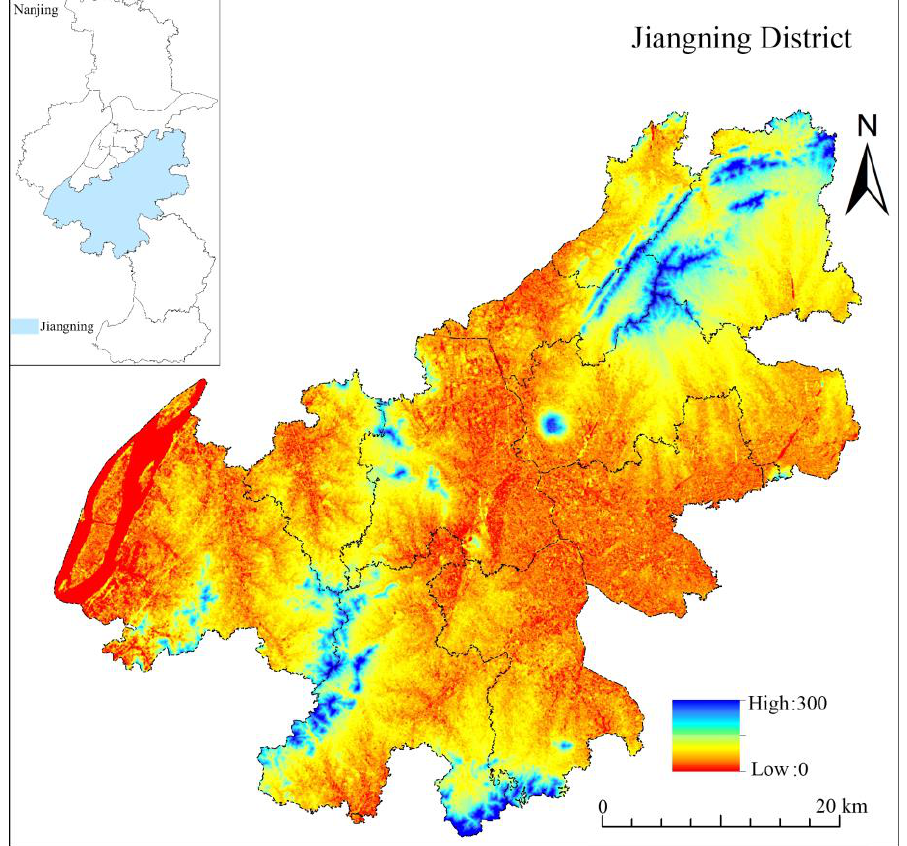
Figure 1. Location of Jiangning District. Table 1. Calculation method and connotation of pattern